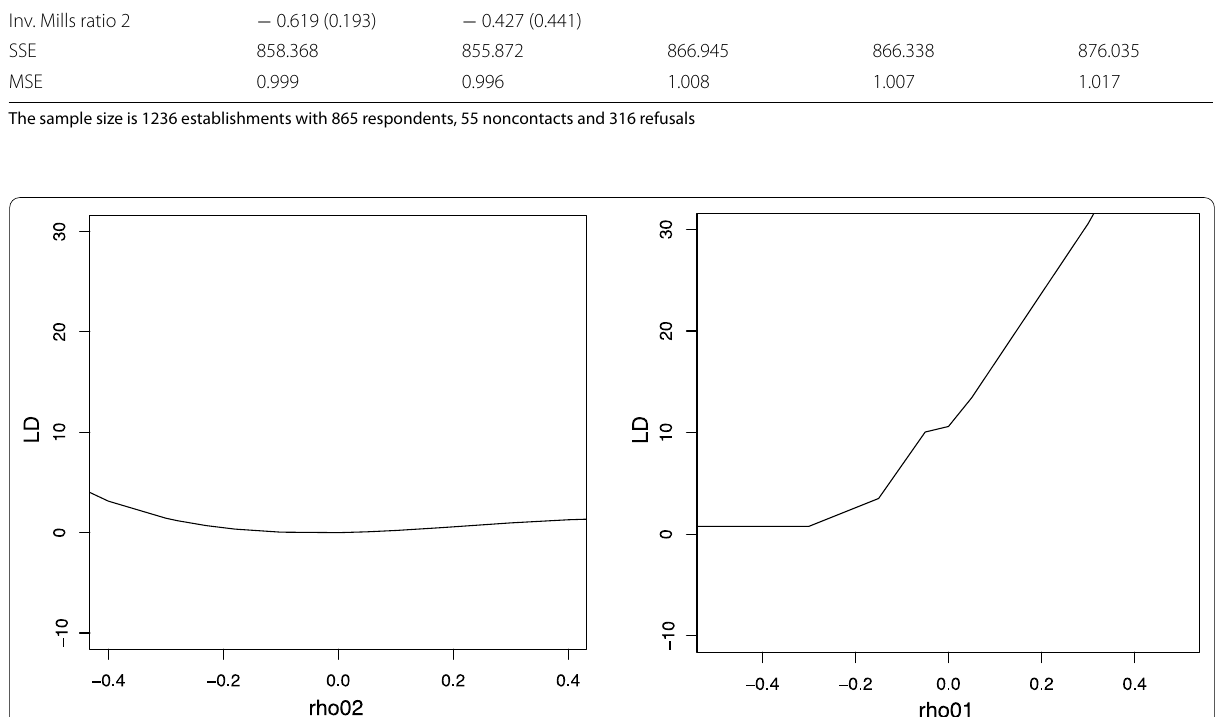
Fig. 3 Sensitivity analysis for the assessing of the influence of the sample selection on deviation from random nonresponse to nonrandom nonresponse, noncontact in the left panel and refusal in the right